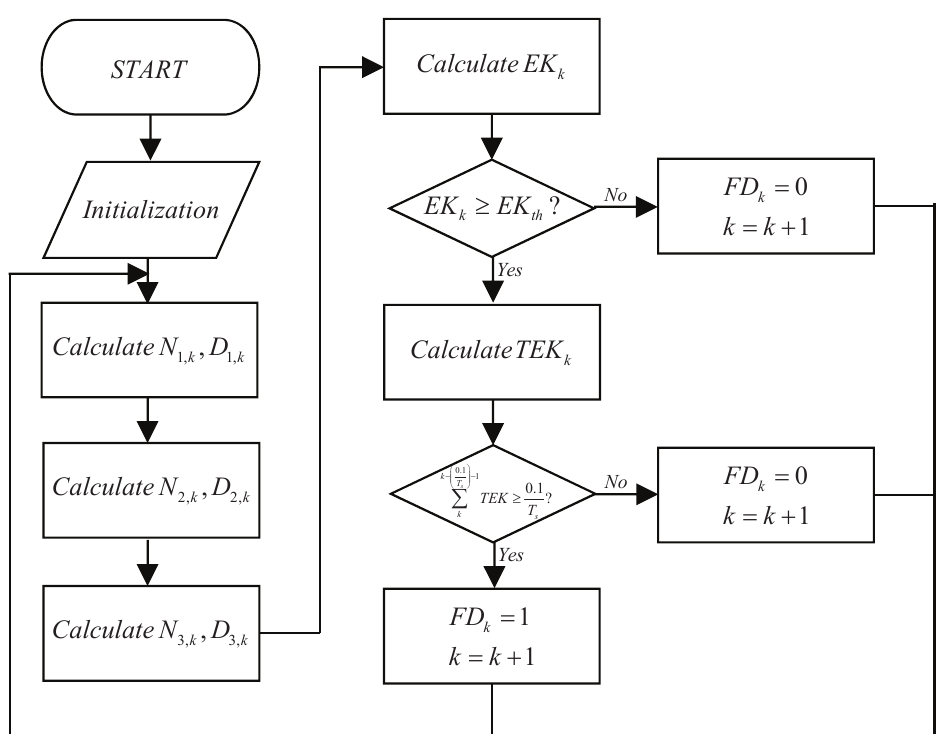
Figure 9. Flowchart of the proposed fault detection